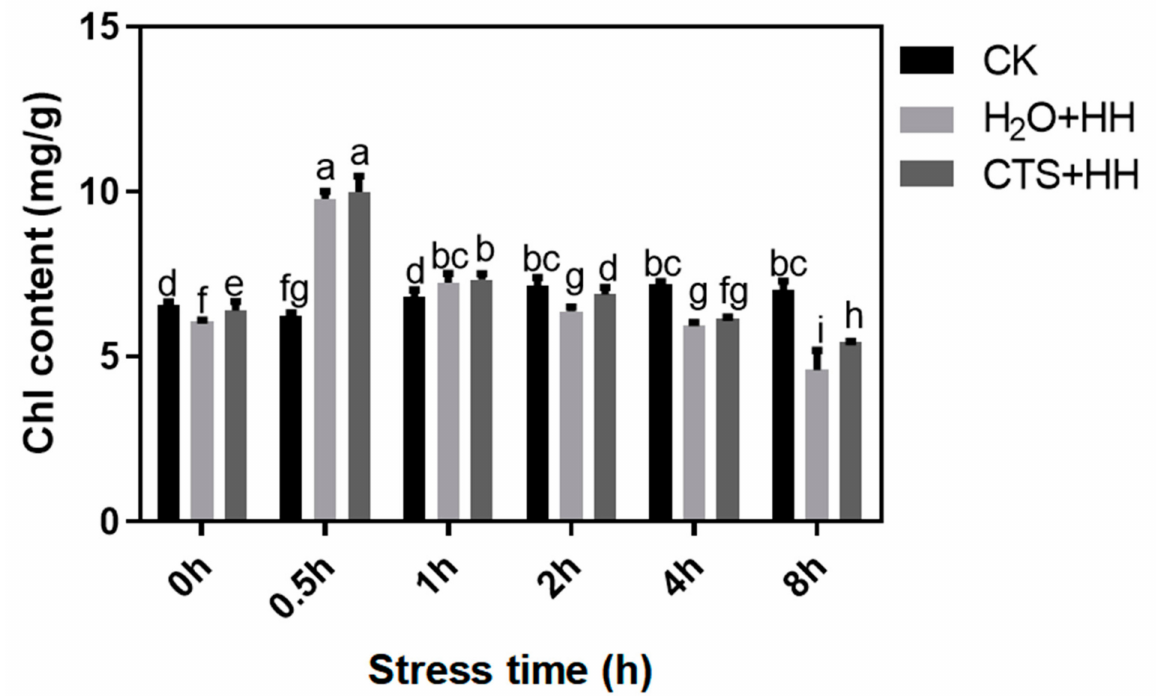
Figure 1. Effect of CTS on the Chl content of leaves of strawberry seedlings under high-temperature and high-light stress. CK: H 2 O + 23 ◦ C + 400 µ mol · m − 2 · s − 1 ; H 2 O + HH: H 2 O + 38 ◦ C + 1800 µ mol · m − 2 · s − 1 ; CTS + HH: CTS + 38 ◦ C + 1800 µ mol · m − 2 · s − 1 . The different lowercase letters indicate significant differences between the treatments (Duncan’s multiple range test; p <